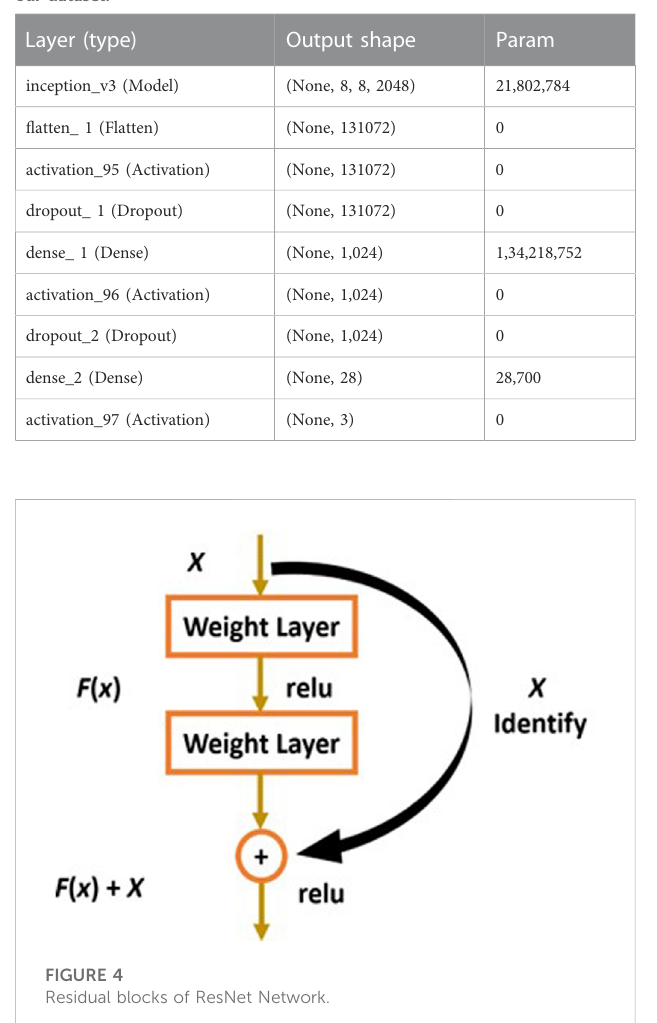
TABLE 2 Hyper Parameters details used in the Inception V3 model according to our dataset.